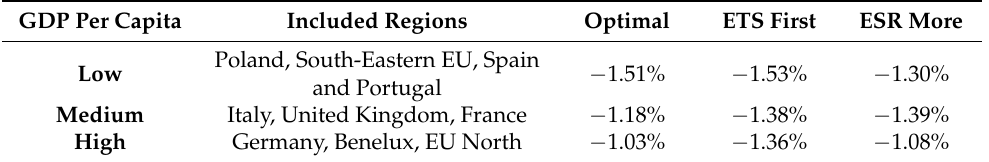
Table 2. 2030 GDP effects relative to the reference scenario. EU regions grouped according to NEWAGE base year GDP per capita.